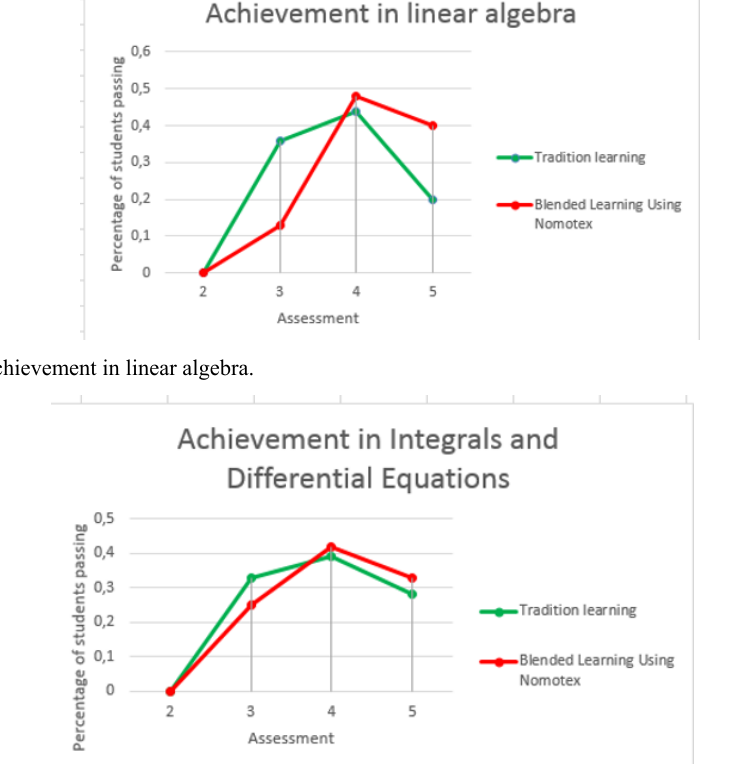
Fig. 3. Achievement in integrals and differential equations.